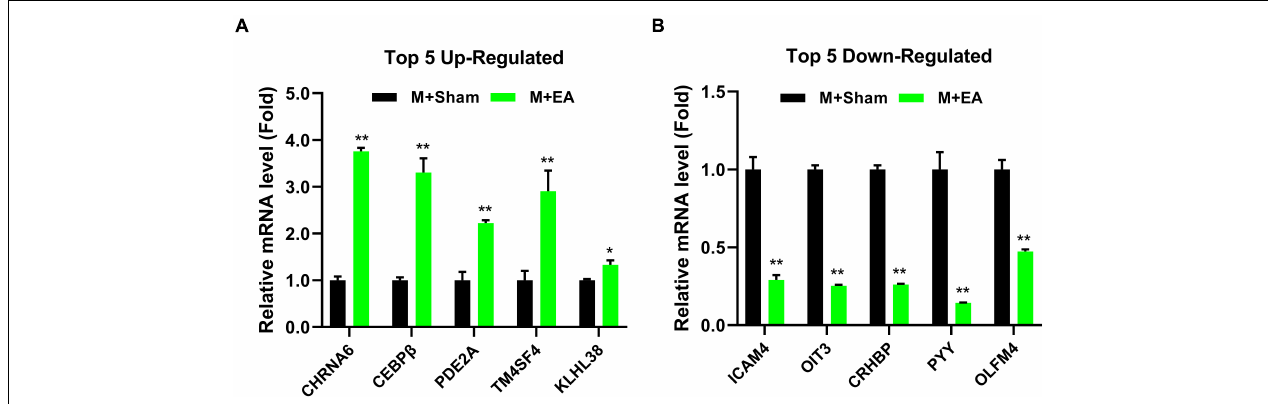
FIGURE 5 | Effects of EA treatments on the expression of gene in the brainstem. (A) The mRNA expression level of top5 up-regulated gene in the brainstem. (B) The mRNA expression level of top5 down-regulated gene in the brainstem ( n = 4). The data were analyzed with unpaired t test. * p < 0.05 and ** p < 0.01 compared to M + Sham.